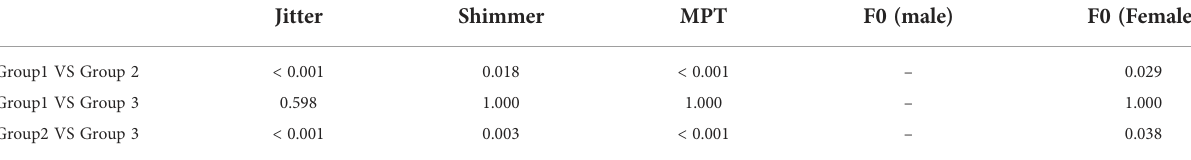
TABLE 2 Pairwise comparison with Bonferroni